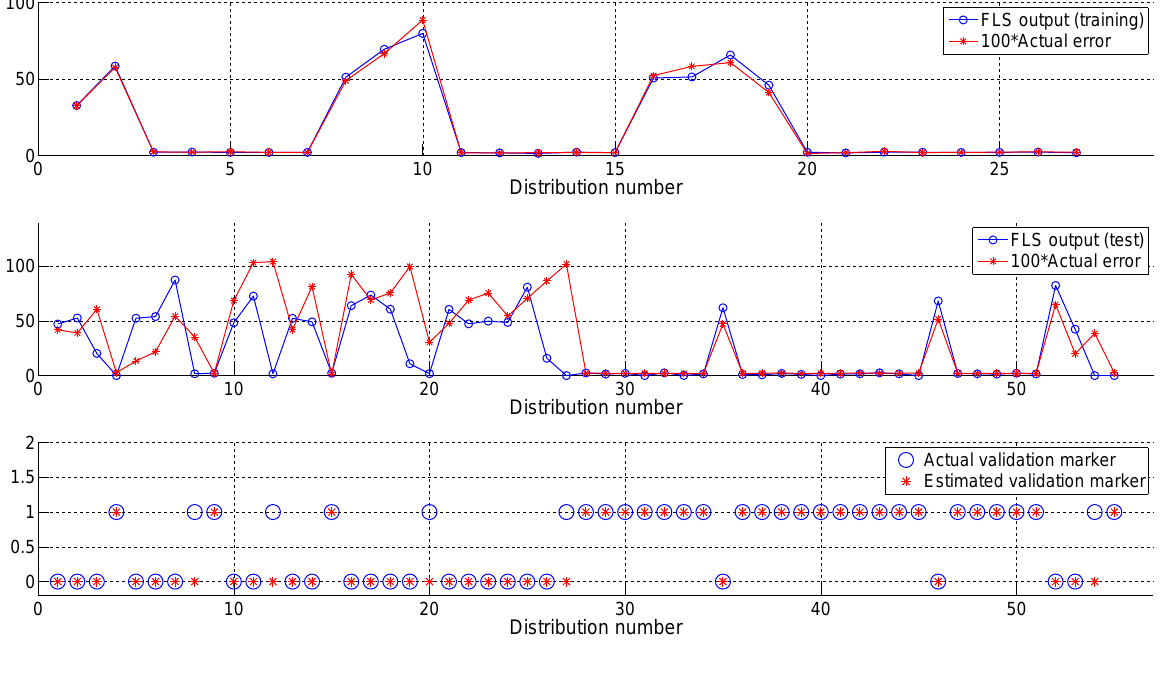
Table 3. Results of the test procedure of the Multiple-indicator Fuzzy Validator. Datasets 1 and